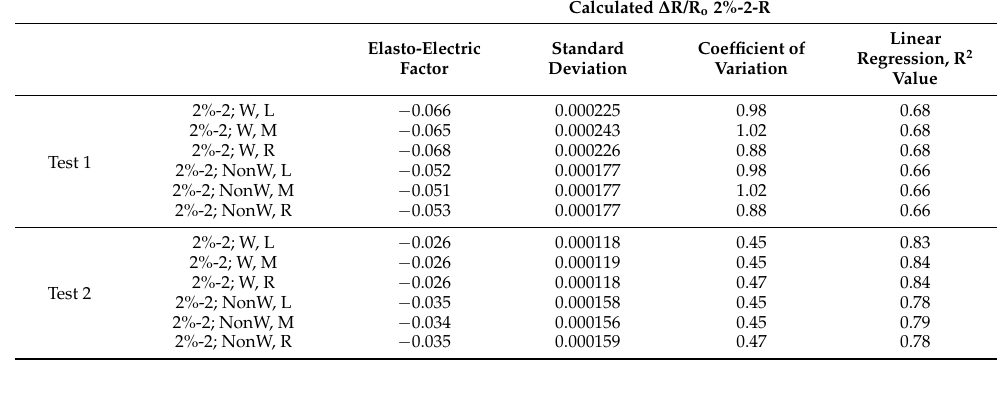
There were also strain variations between the wire and non-wire faces, which indicates eccentricity developed in the column (Figure 13). This may be caused by uneven